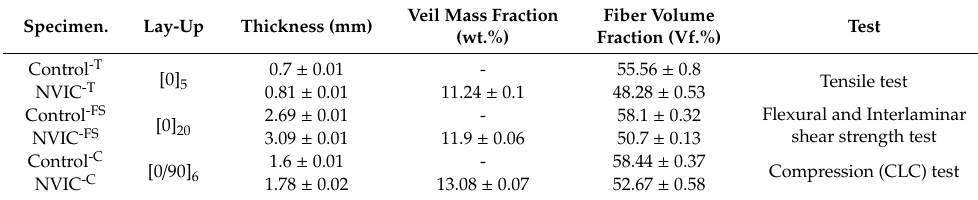
Table 6. Characteristic of specimens for mechanical properties